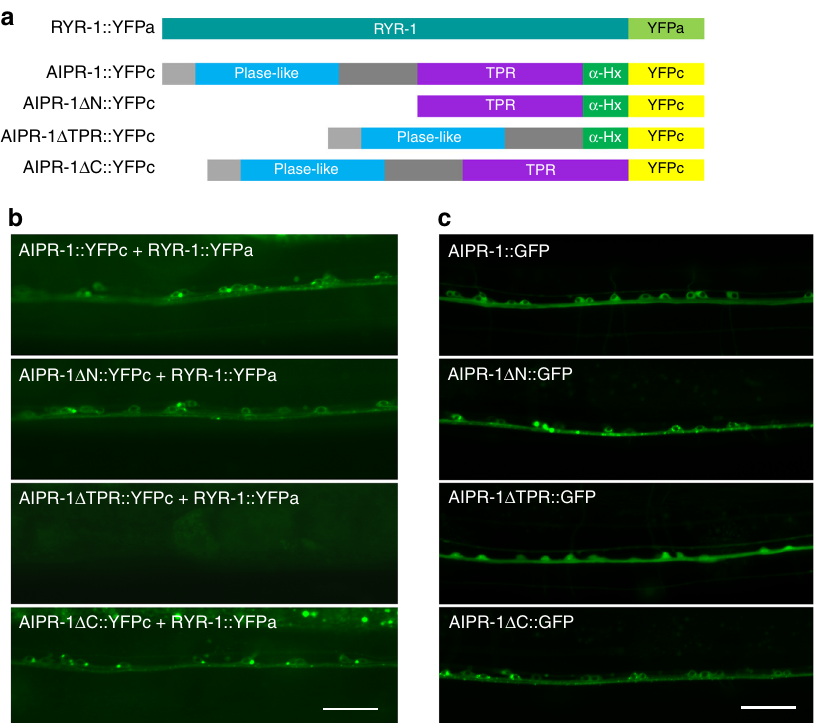
Fig. 7 Bimolecular fl uorescence complementation between AIPR-1 and RYR-1 in vivo. a Schematic diagrams showing the various fusion proteins used in the bimolecular fl uorescence complementation assays. b Deletion of the TPR domain but not any other parts of AIPR-1 prevented AIPR-1::YFPc from reconstituting YFP fl uorophore with RYR-1::YFPa in ventral cord motor neurons. c GFP-tagged AIPR-1 with the various deletions showed comparable expression levels in ventral cord motor neurons. Scale bars, 20 µ fusion proteins were coexpressed in neurons (Fig. 7b). YFP fl uorescence was also observed when either the prolyl isomerase domain or the C-terminal α -7 helix was deleted (Fig. 7b).